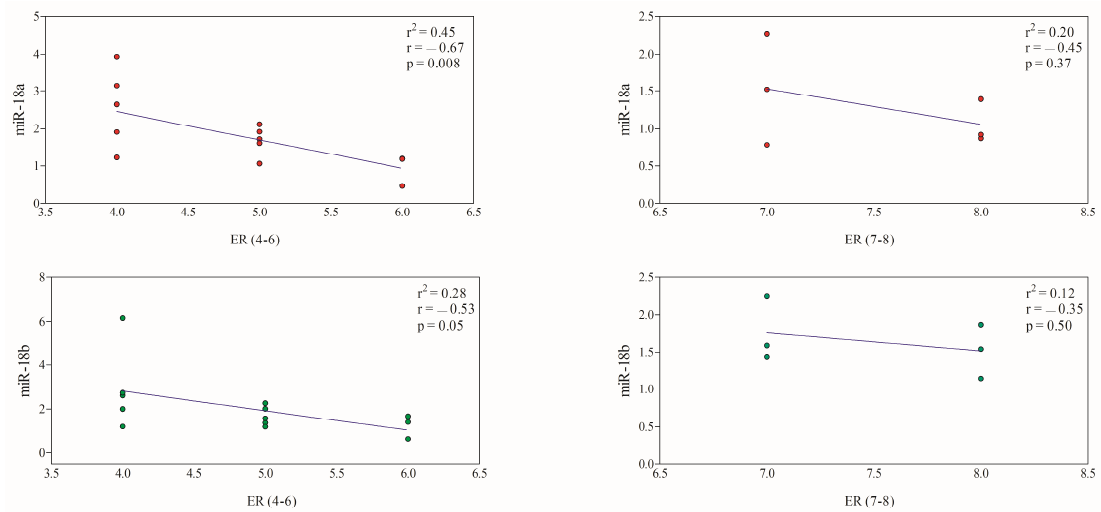
Figure 3. Correlation between miRNA expression and ERα score . A significant negative correlation was observed for both miR-18a (red circles) and miR-18b (green circles) in CMTs with lower ERα immunoexpression. The colored circles (red; green) refer to miRNA expression levels in CMTs. The expression levels of miR-18a showed a significant negative correlation with a Ki67 index < 33.3%, while it was not correlated with a Ki67 index > 33.3%. The miR-18b gene expression did not show a significant correlation with a Ki67 index < 33.3% and > 33.3% (Figure 4).